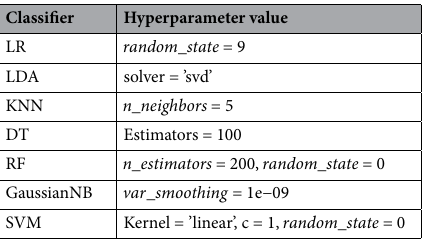
Table 1. Machine learning model’s hyperparameter.